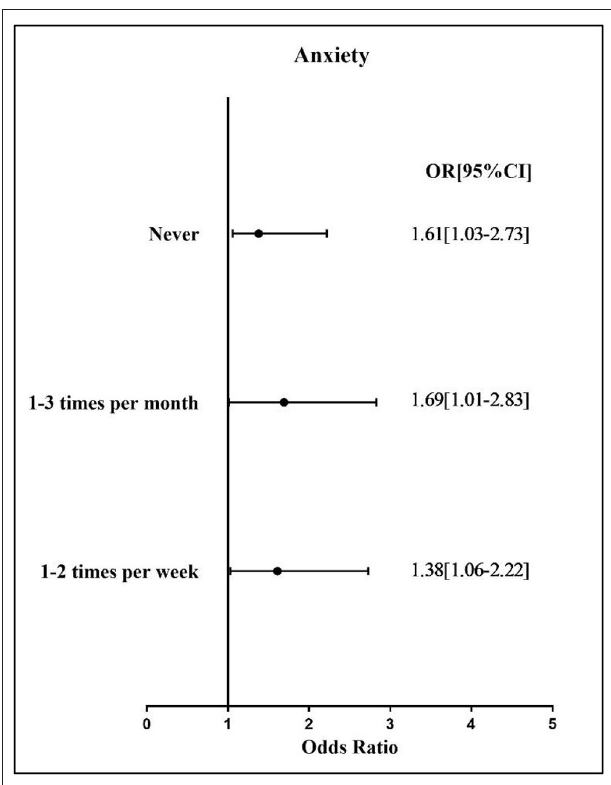
FIGURE 1 | Association between sport participation and depressive symptoms severity. OR, odds ratio; CI, confidence interval. Reference group: 3 or more times per week.